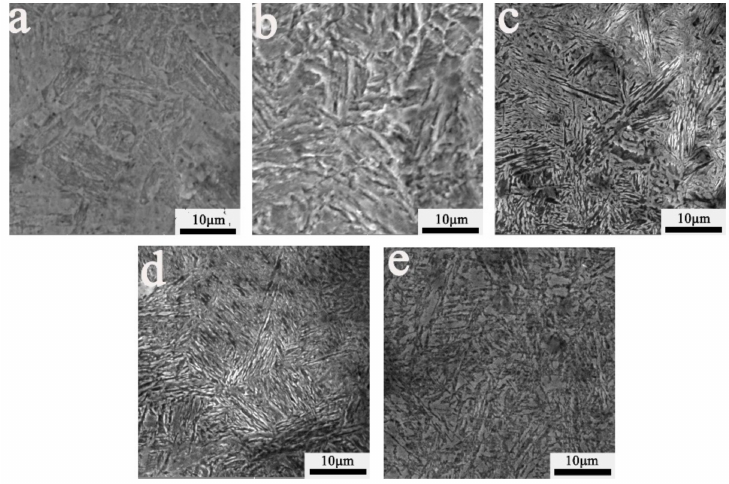
Figure 7. The microstructure of remelting zone of biomimetic unit: ( a ) LR-A1, ( b ) LR-A2, ( c ) LR-A3, ( d ) LR-A4, and ( e )